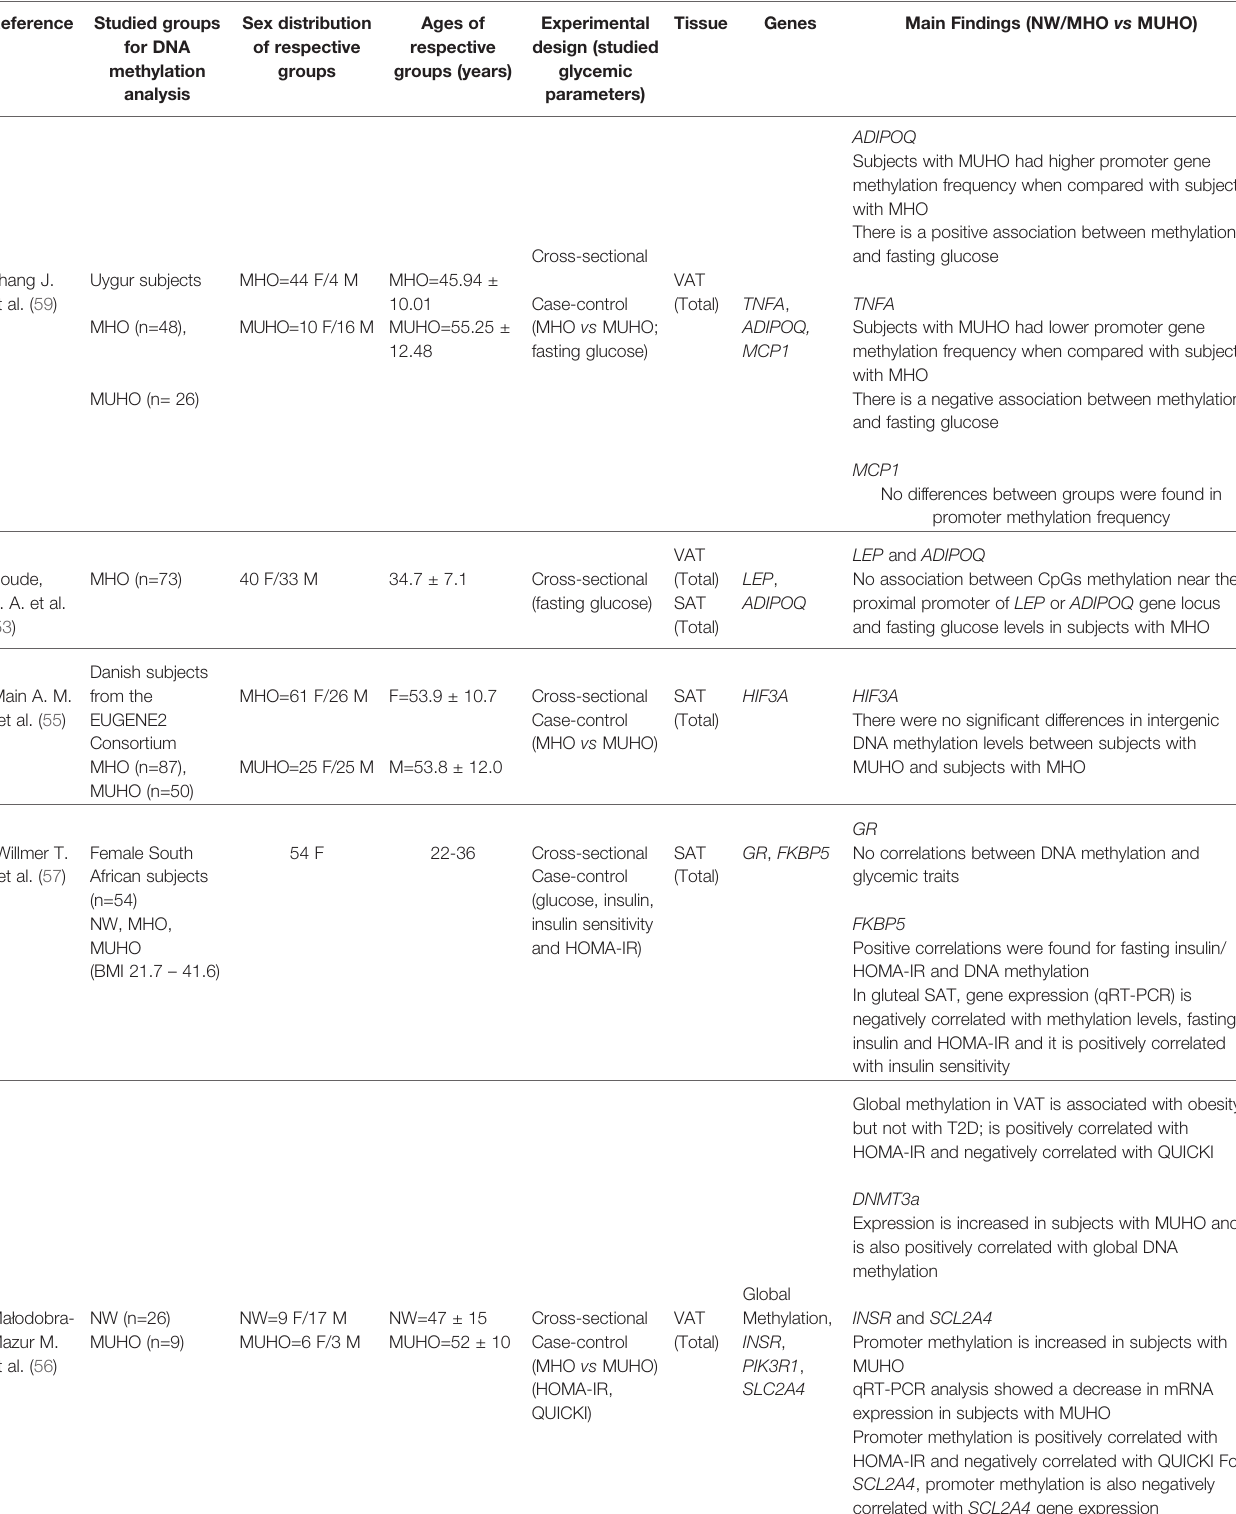
Reference Studied groups for